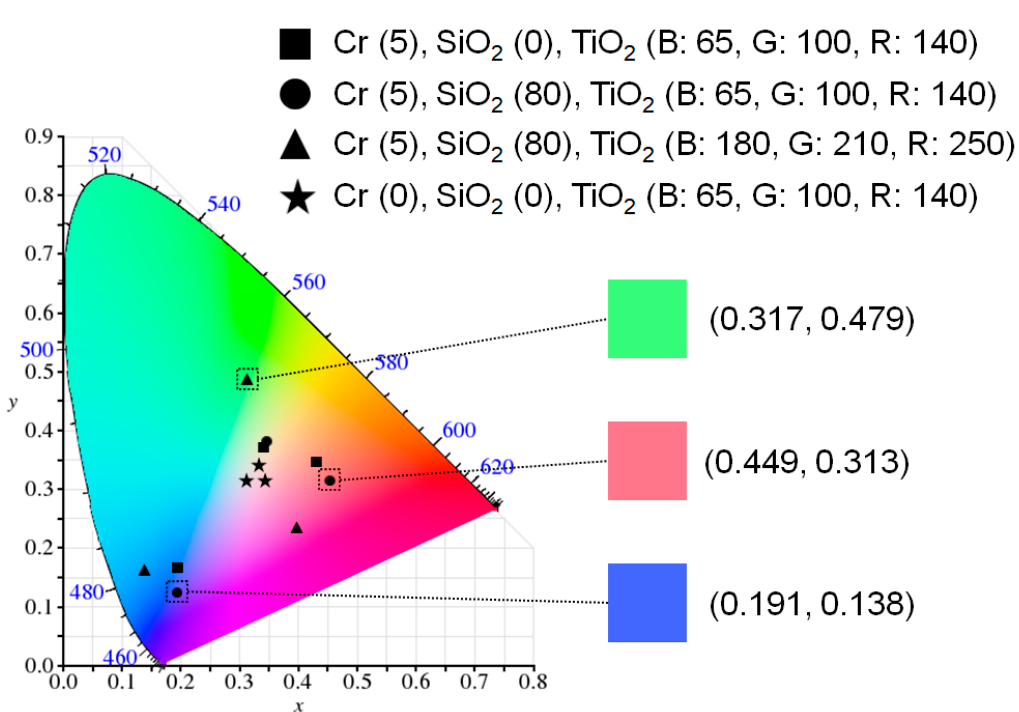
Figure 4. A representation of color coordinates calculated from the reflection spectra studied in Figure 3 illustrated on the CIE 1931 chromaticity diagram.